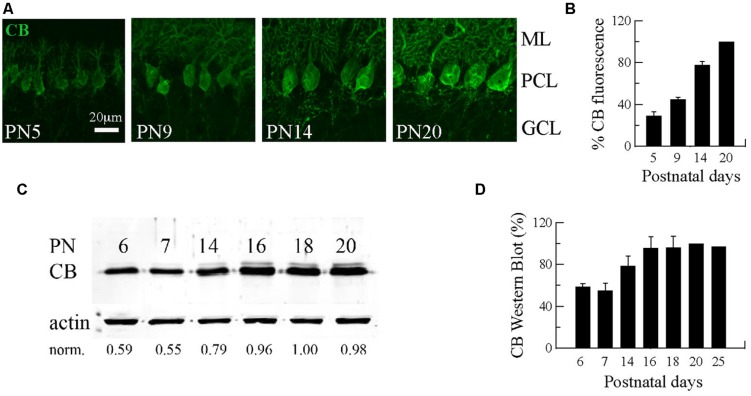
Developmental regulation of calbindin-D28k (CB) expression in mouse cerebellar PC. (A) Confocal images of the cerebellar cortex at different ages from PN5–PN20 on sagittal slices treated with anti-CB antibodies. The expression of CB is detected early during the first PN week in dendrites, somata and axons of PC. The intensity of IHC signals increases progressively until PN20. (B) Mean CB fluorescence values of the PC layer at different ages (n = 3 mice per age). Data are normalized to PN20. (C) Age-dependent increase in the total CB protein expression levels from PN6–PN20 determined by quantitative Western blots (average from 2 independent experiments, n = 3 mice per time point). The actin signal was used for normalization (norm.). In each of the 2 experiments, the normalized signal at PN20 was set as 1.00. (D) Pooled data for Western-blots of cerebella from PN6–PN25 (n = 3 mice per age) reached a plateau in CB expression at the end of the third week (ML, molecular layer; PCL, Purkinje cell layer, GCL, granule cell layer).